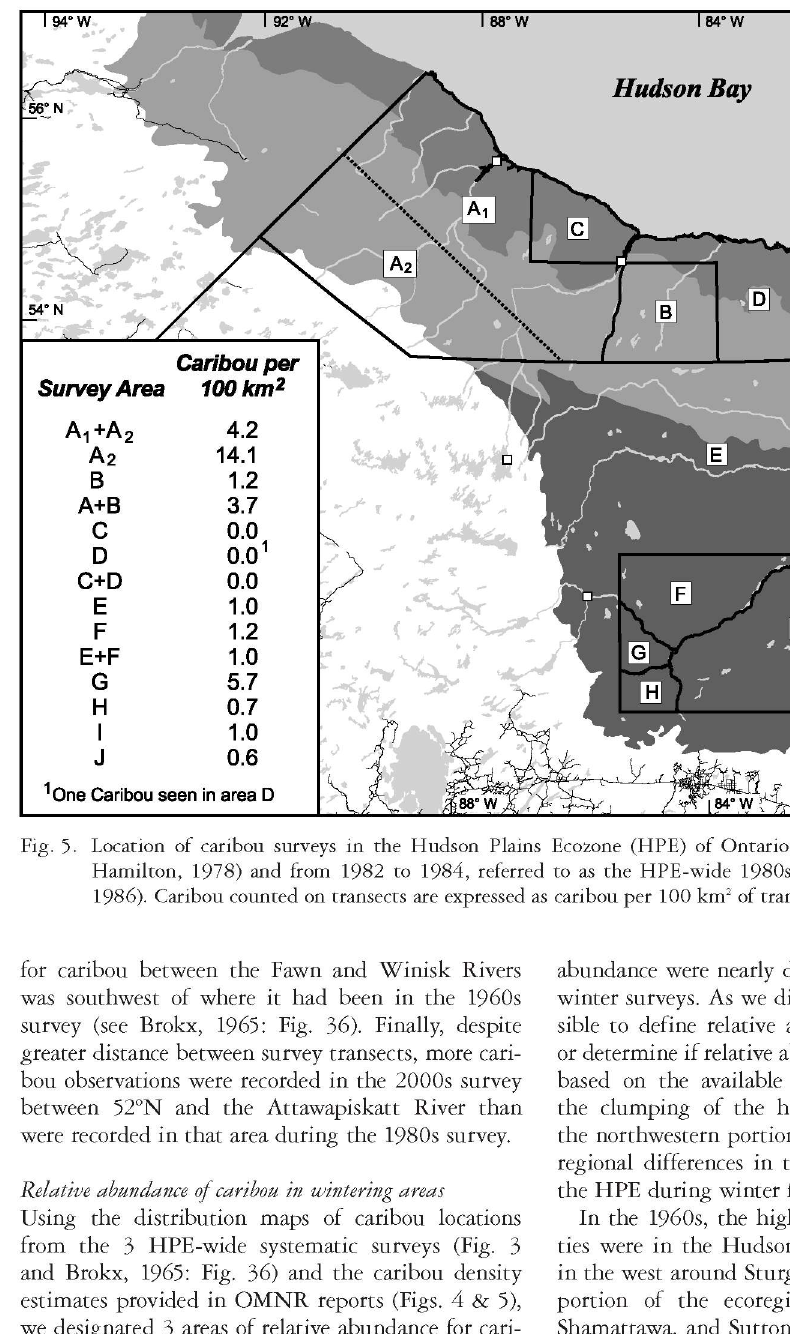
(Fig. 4: area 1) and the James Bay Lowland (Fig.